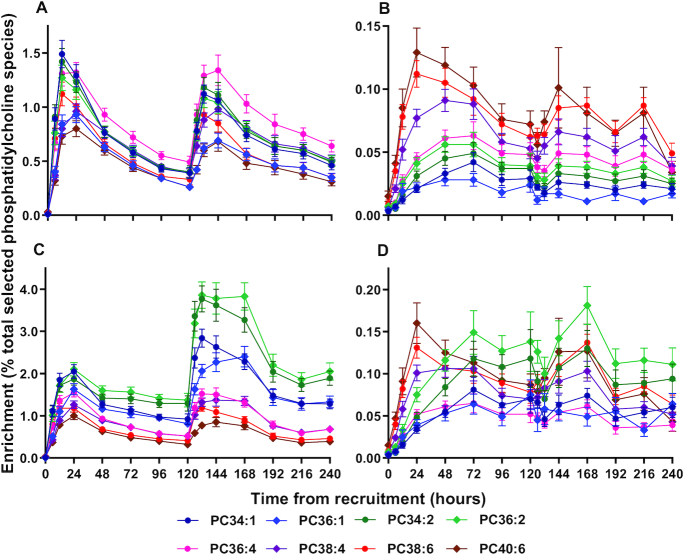
Enrichment of methyl-D9-choline into individual molecular species of plasma PC. Results are presented for incorporations into methyl-D9-PC (A, C) and methyl-D3-PC (B, D). The results in panels A and B were expressed as percentage labeled:labeled + unlabeled PC. Panels C and D present the same results after normalization to initial concentrations of individual PC molecular species at t = 0 h. Results are presented as means ± SEMs; numbers at each time point were the same as in Figure 4A. PC, phosphatidylcholine.